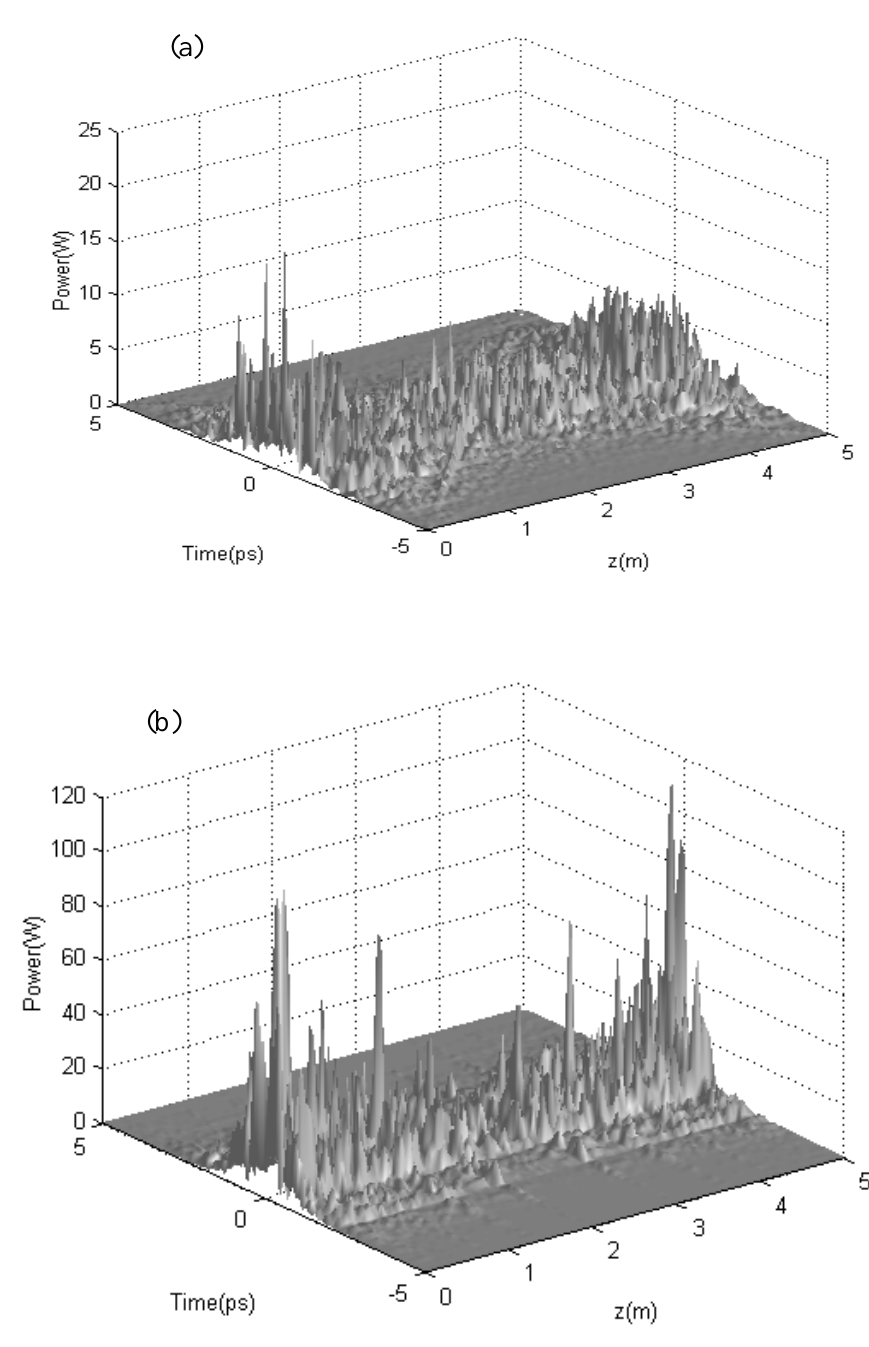
Fig.5: Evolution of substructure in a 5-m ring resonator when pulses growth from spontaneous emission, with GVD (a)β =-0.014ps 2 /m (b) β =-0.012ps 2 /m and parameters are γ=0.012(Wm) -1 , 2 2 α =0.3, T =0.047ps, α=0.1782m -1 and =0.7827m -1 2 2